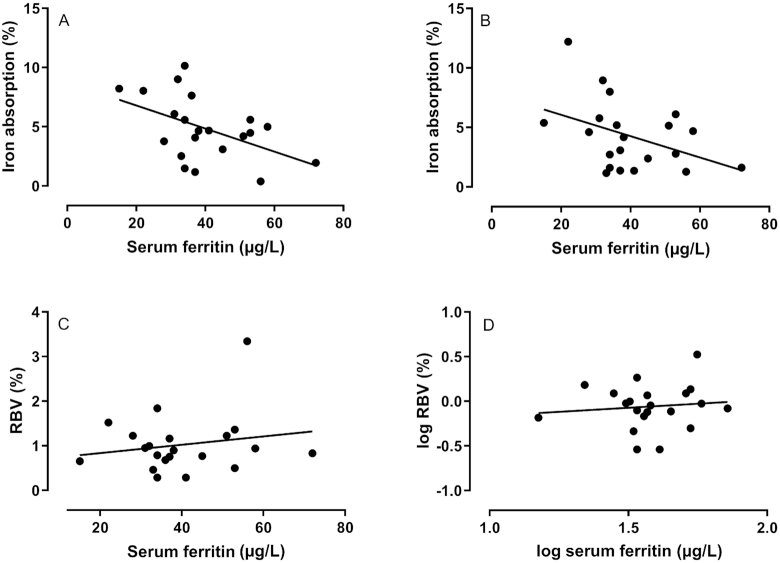
Linear regression relations between serum ferritin and iron absorption from ferrous sulfate (A; r = −0.43, P = 0.051), serum ferritin and iron absorption from an iron–casein complex (B; r = −0.39, P = 0.080), serum ferritin and the RBV of ferrous sulfate/iron–casein complex (C; Spearman rank correlation coefficient r = 0.04, P = 0.850), and log serum ferritin and log RBV of ferrous sulfate/iron–casein complex (D) obtained in young nonanemic women (n = 21) who consumed a milk drink containing an iron–casein complex or ferrous sulfate. Regression analyses were performed on log-transformed data. RBV, relative bioavailability value.